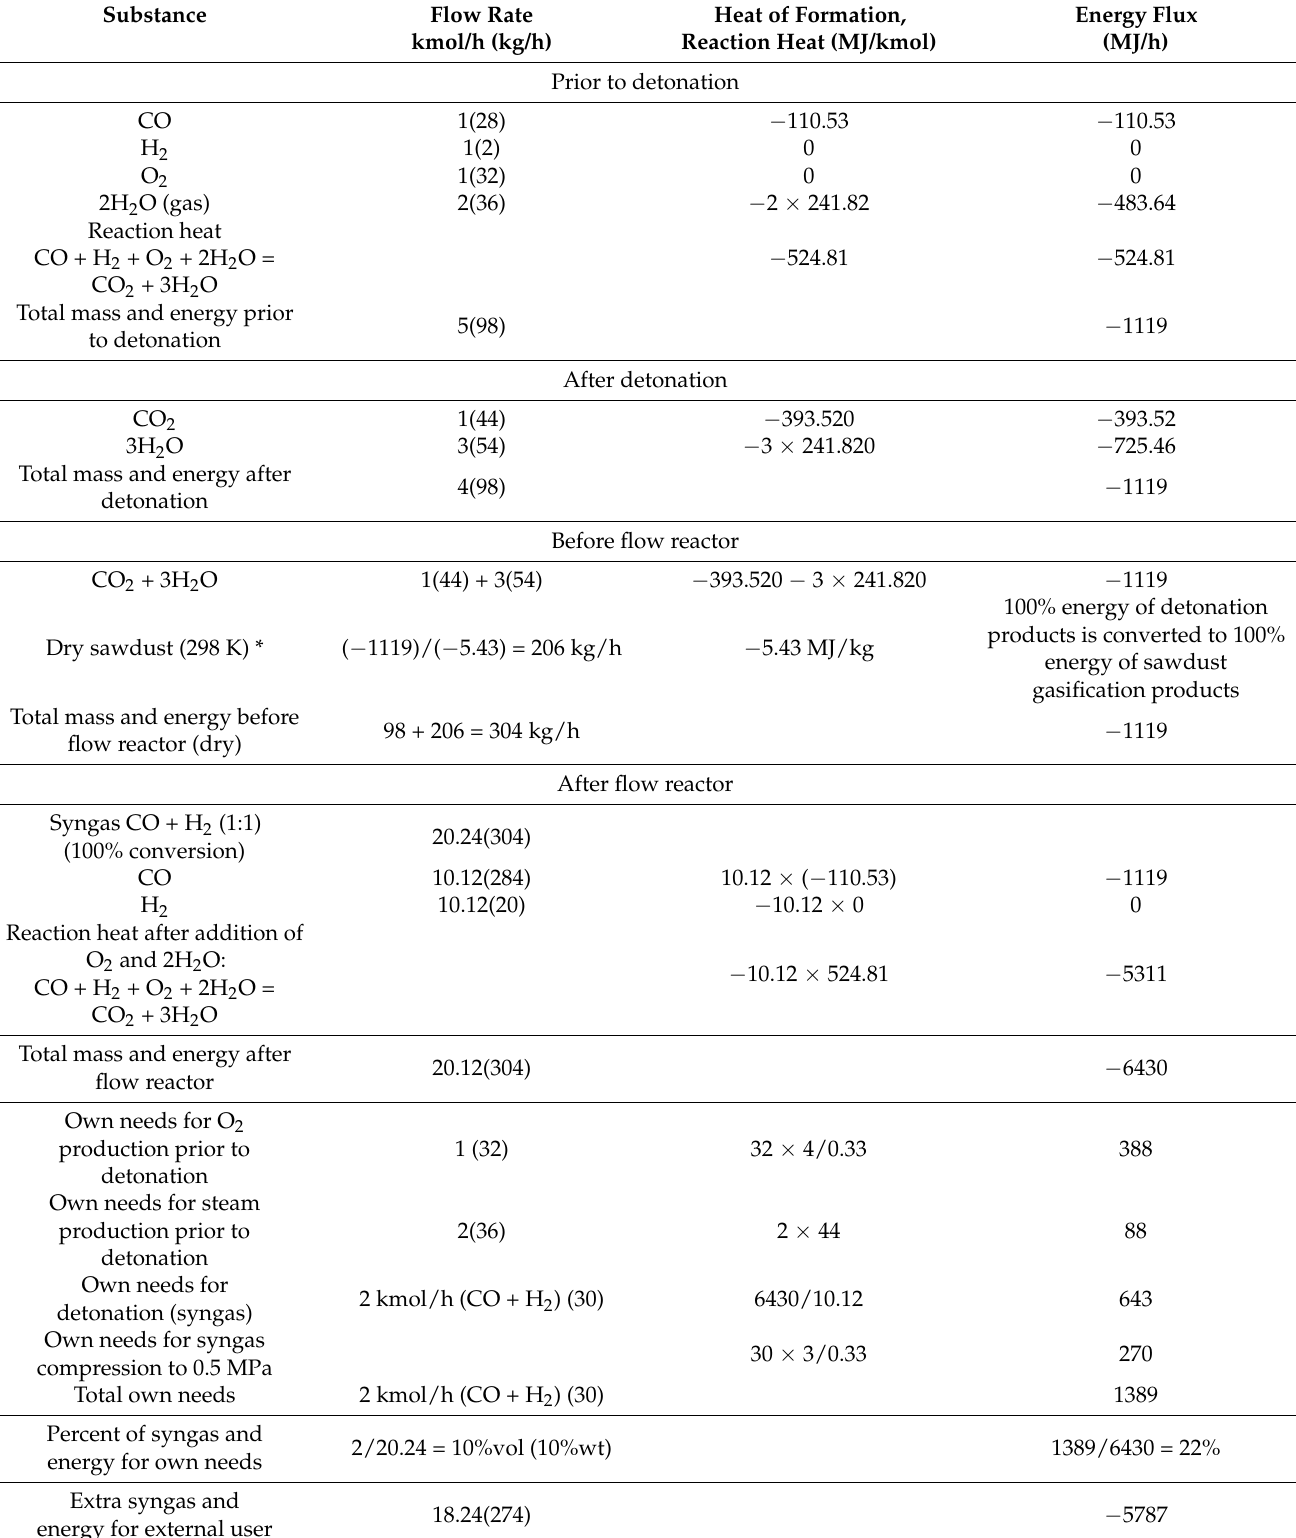
Table 4. Mass and energy balances (without losses) for dry